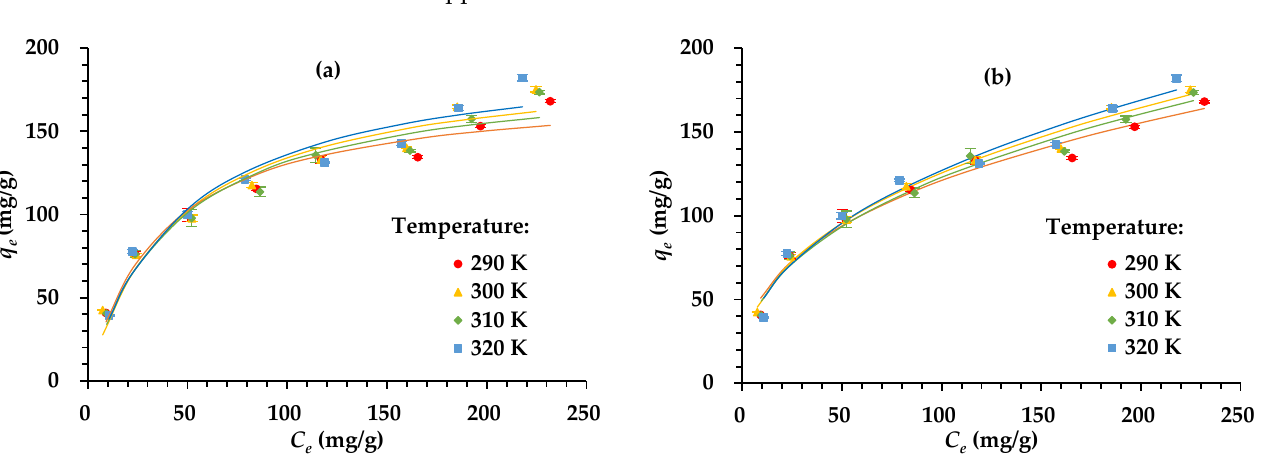
Figure 5. ( a ) Langmuir and ( b ) Freundlich isotherms for Cu(II) adsorption onto poly(acrylic acid/chestnut shell pigment) (Contact time = 24 h, pH = 6, adsorbent dosage = 1 g/L). Table 2. Isotherm parameters of Cu(II) adsorption onto poly(acrylic acid/chestnut shell pigment) at contact time = 24 h, pH = 6, adsorbent dosage = 1